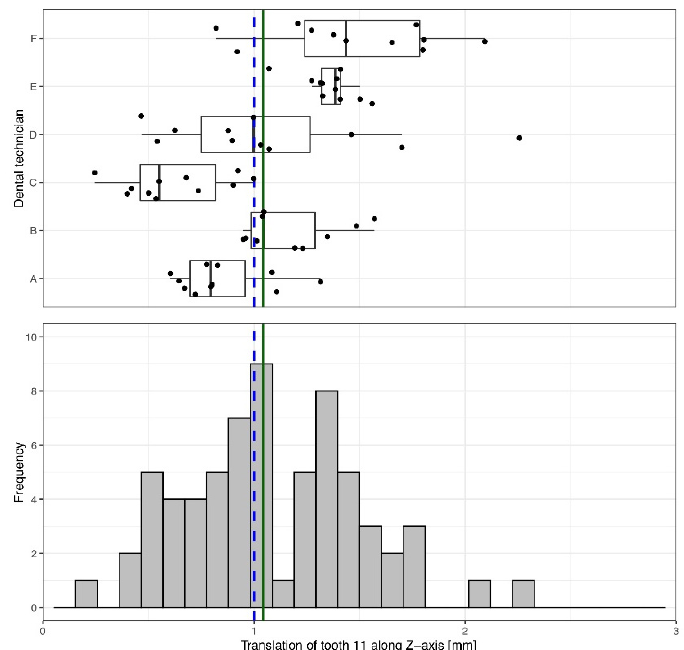
Figure 4. Determined orovestibular ( z -axis) translational movement of tooth 11. A movement of 1 mm (blue dashed line) was specified. Across all technicians, a median movement of 1.04 mm (green solid line) was achieved. The box-and-whisker plot in the upper panel shows the measured movements of each individual dental technician. The histogram in the lower panel depicts the overall distribution of the measurements.